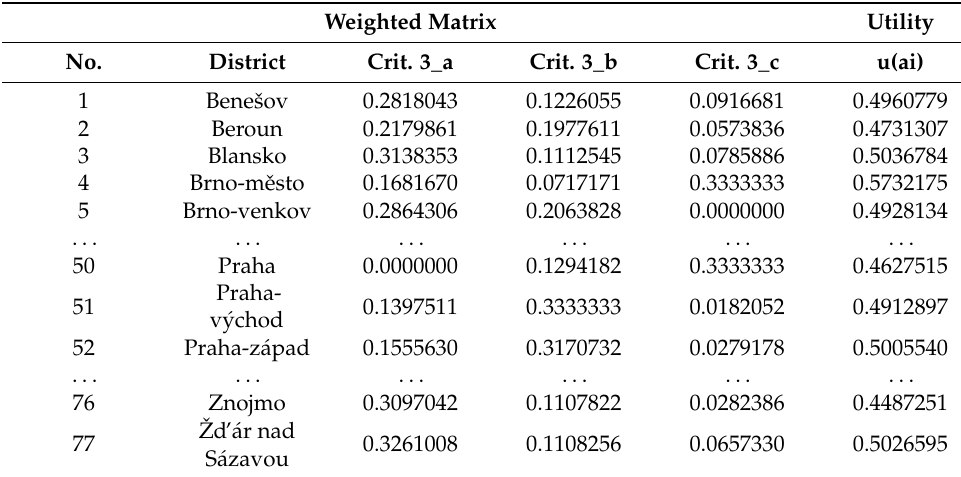
Table A4. Results of WSA for 3. area (weighted matrix and utility of each district). Weighted Matrix Utility No.